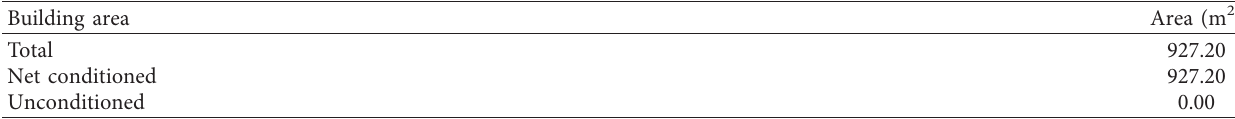
Table 1: Details of the building under study.